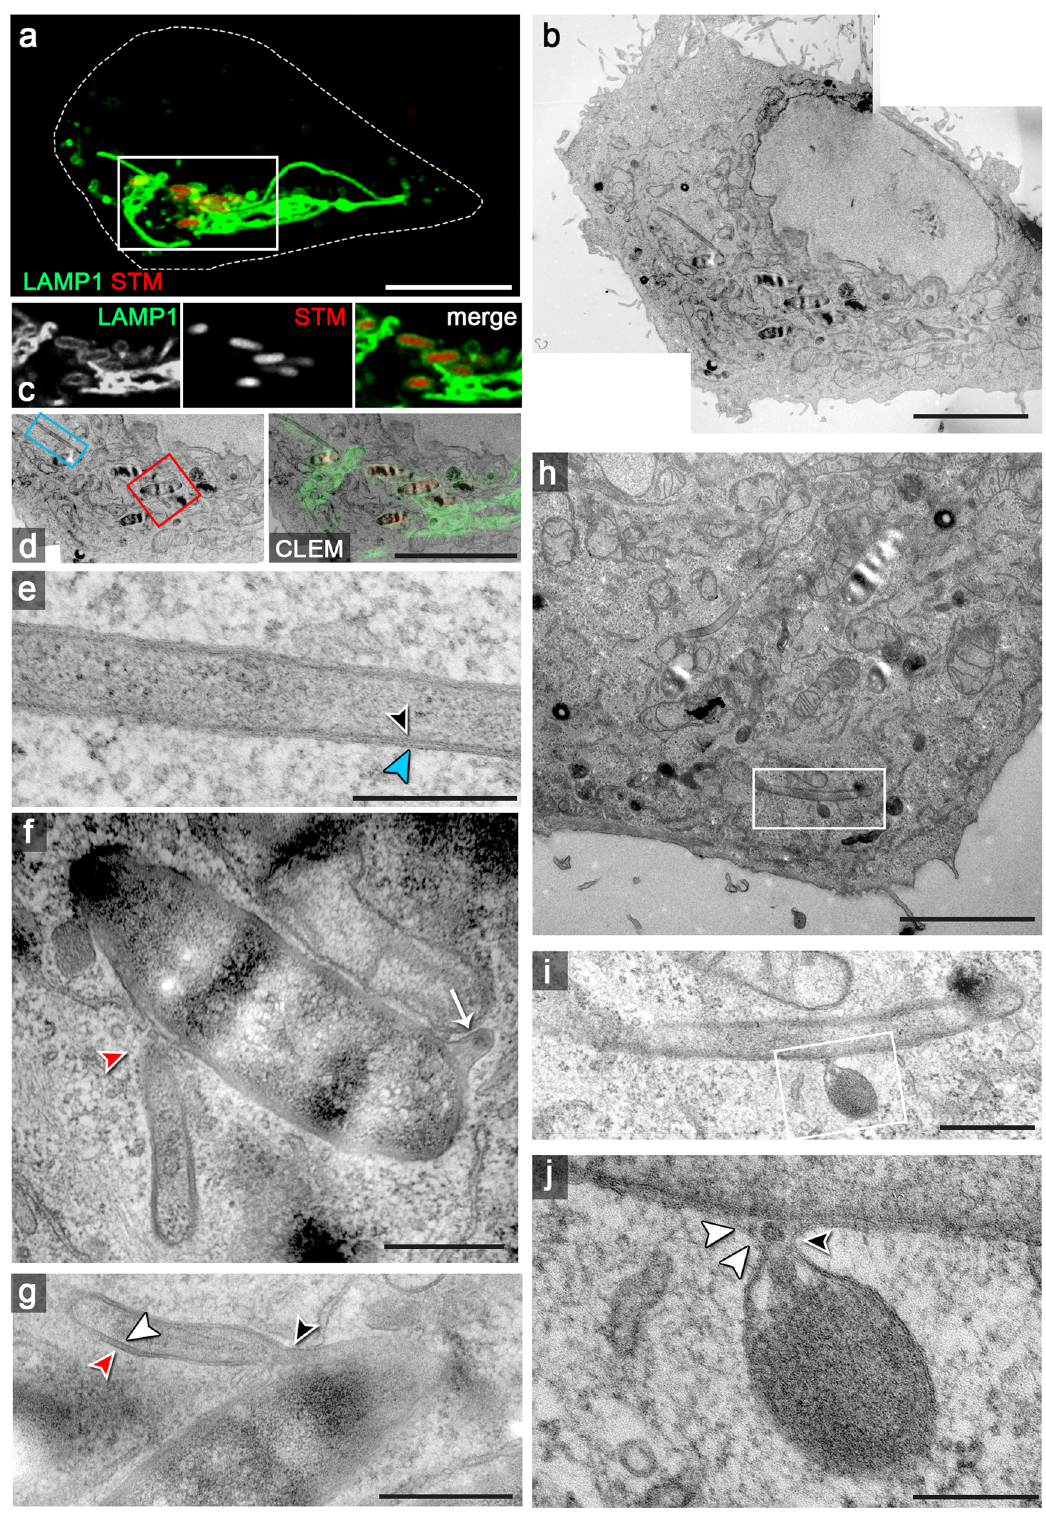
Fig. 1 | Interactions of host cell endosomal membranes in STM-infected cells. HeLa cells stably expressing LAMP1-GFP (green) were infected with STM WT expressing mCherry (red) and CLSM was performed ( a , c ) to identify SIF-positive cells showing dynamic extension of SIF networks. Cells were fi xed 7h p.i., coordi- natesregisteredandsampleswereprocessedforTEM( b ).CorrelationofCLSMand TEMmodalitiesallowedidenti fi cationofSTMinSCVandextendingSIFtubules( d ). Regions of interest are indicated by boxes and details show a double-membrane